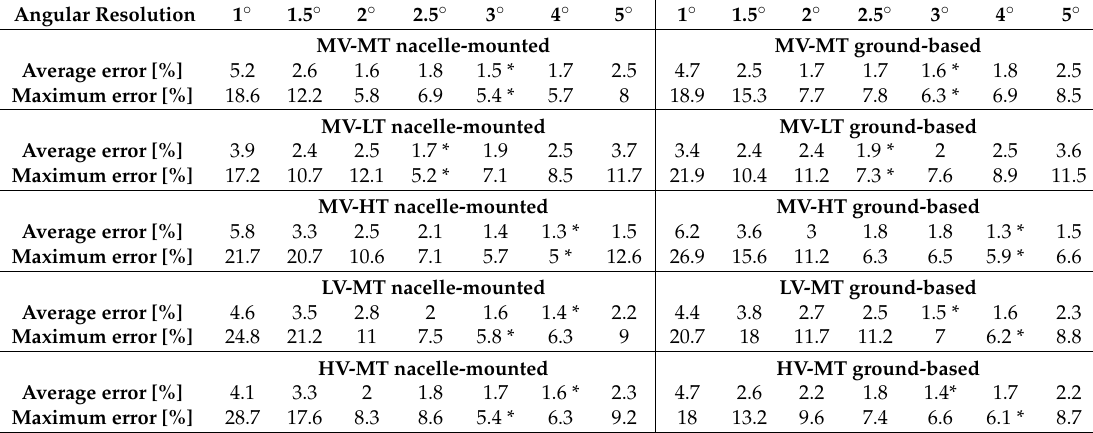
Table A1. Total average and maximum errors for the reconstruction of u ( x , y , z ) inside the volume of interest for all inflow cases studied and both lidar locations. The errors are shown as a percentage of the undisturbed wind speed at hub height (see Section 2.1.3). The errors corresponding to an optimum angular resolution for each case are identified with an